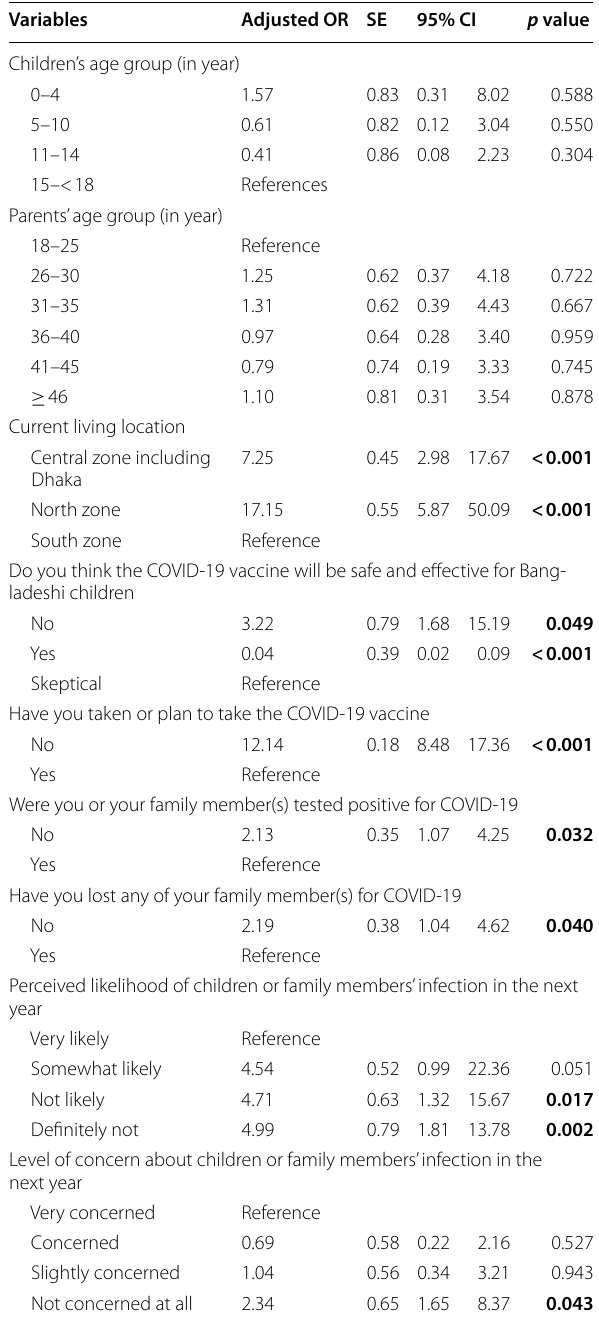
Bold faces are significant at a 5% significance level